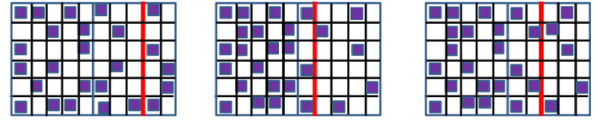
FIG. 1. The model used as a basis the quantitative definition of entropy and the 2nd law of thermodynamics in both courses. Three configurations of a system of 25 particles in a lattice with 60 sites, with a separating, nonpenetrable membrane. Five particles are located at the right side of the membrane and 20 are at the